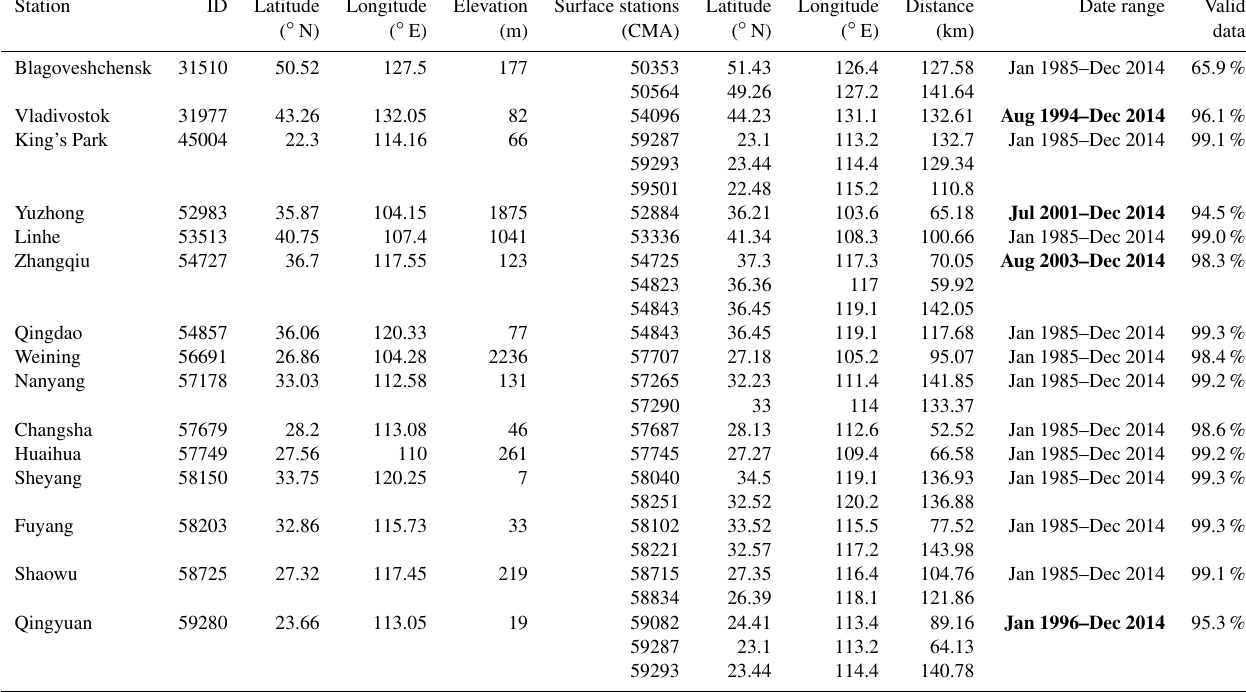
Table B1. Same as Appendix A, but for the 15 radiosonde stations and corresponding surface stations within 150km.